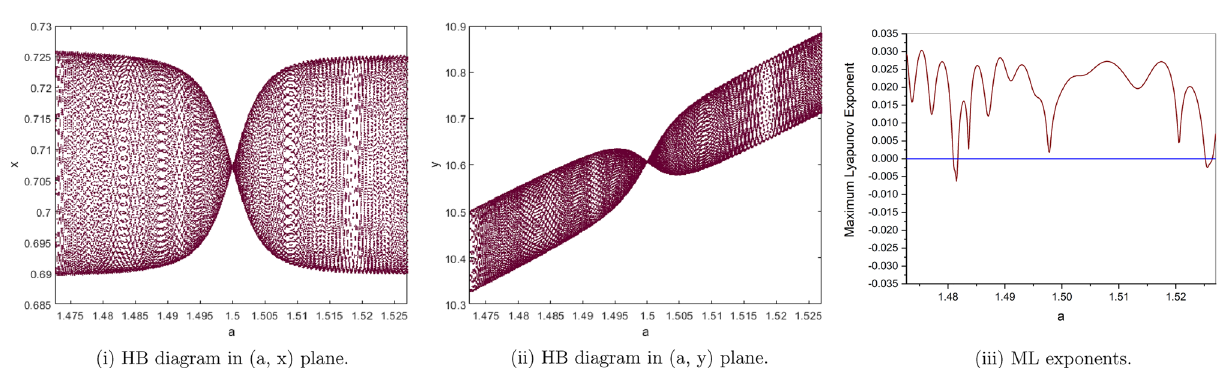
Figure 12. Bifurcation diagrams and ML exponents for the model (i) for values of b = 0.5, c = 0.1, e = 2, h = 3.75, a ϵ [1.4727,